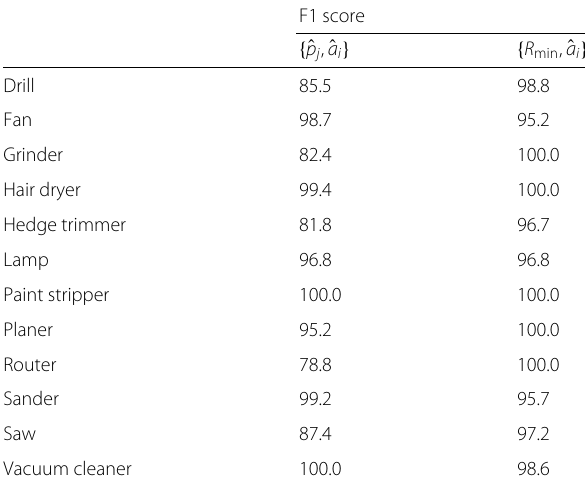
Table 2 Comparative F1 scores of the different COOLL appliances for the classification result using the two sets of features {ˆ p j , ˆ a i } and { R min , ˆ a i } , j = 0, . . . , 3, and i = 1, . . . ,